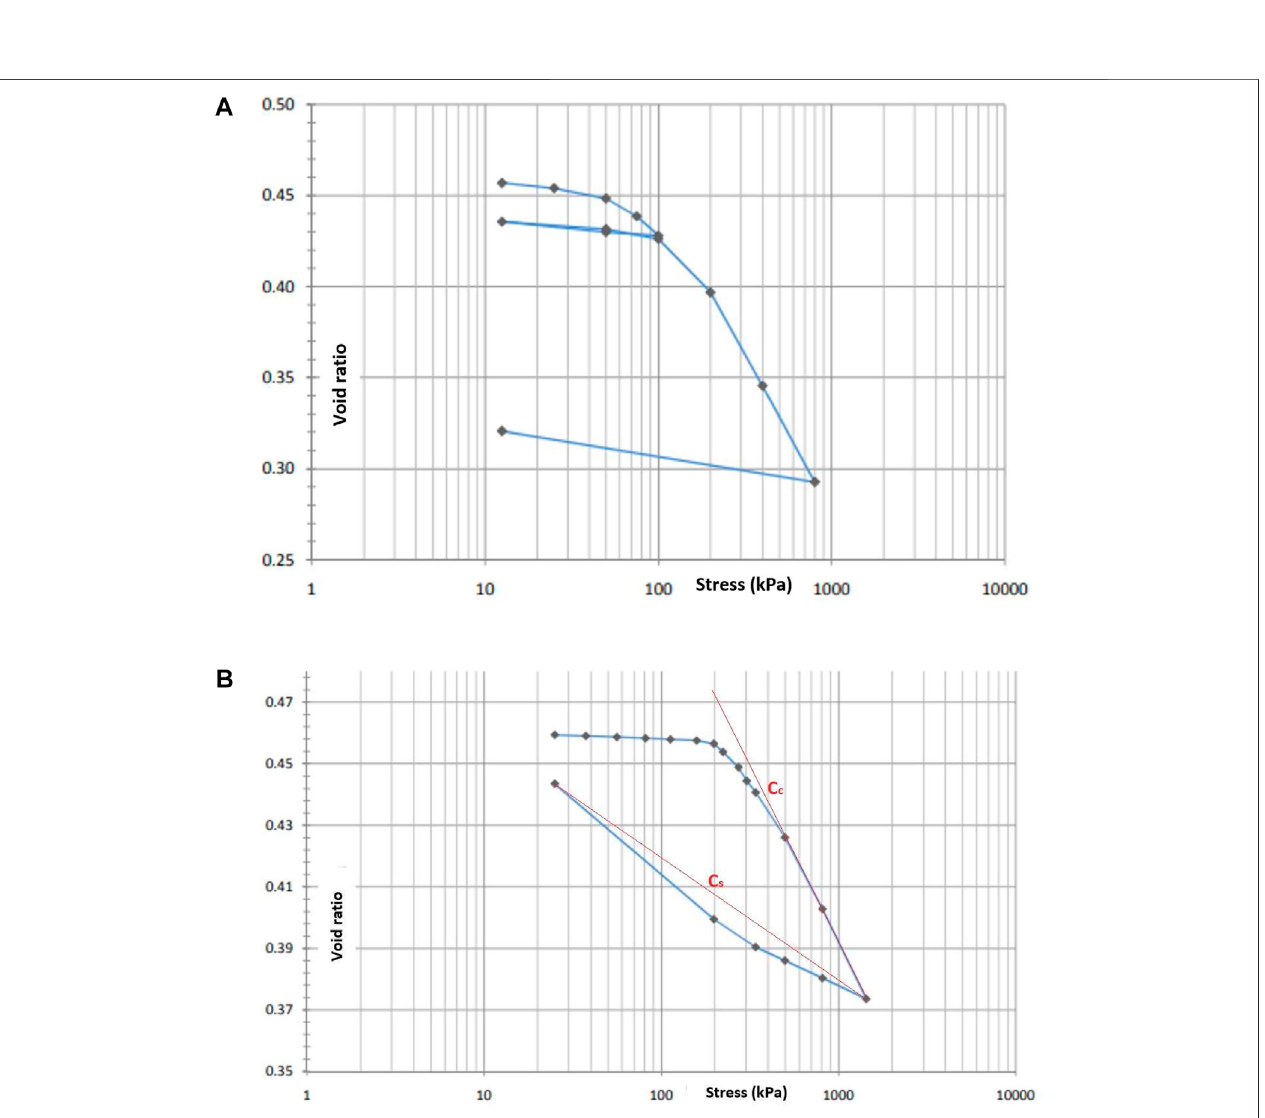
FIGURE 7 | (A) Oedometer curve of a Tunis El Manar University ’ s non-expansive soil (SC2-EI21 sample) with C c /C s = 19.2. (B) Oedometer curve of a Tunis El Manar University ’ s expansive soil (SC1-EI14 sample) with C c /C s = 4.2.